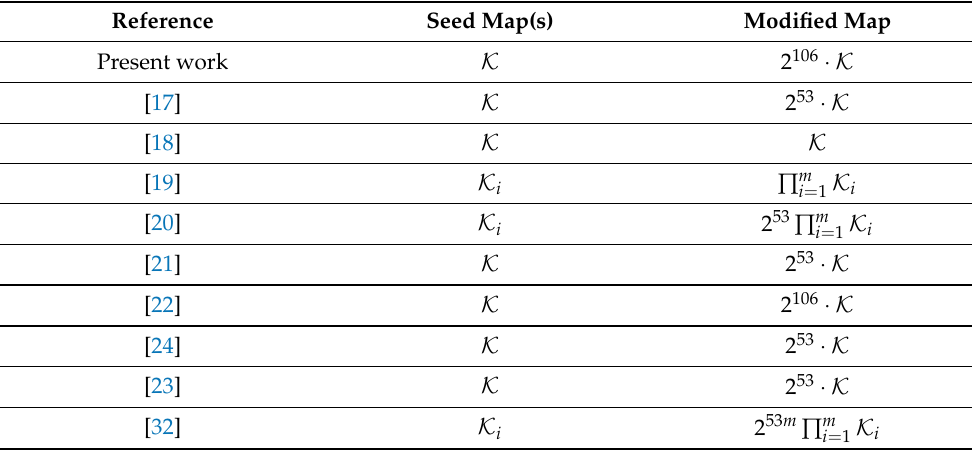
Table 1. Comparison of key space increase for different chaotification techniques. Reference Seed Map(s) Modified